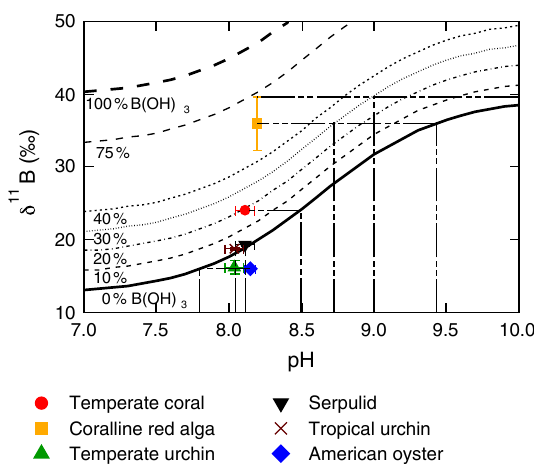
Figure 5. Exploring the potential influence of pH and boron spe- ciation on δ 11 B CaCO (adapted from Rollion-Bard et al., 2011b). 3 The solid and dashed curves represent the δ 11 B CaCO that would 3 result from the incorporation of different amounts of B(OH) 3 into the biogenic carbonates. The dashed vertical lines represent the cal- culated pH CF based on the assumptions that 0% B(OH) 3 is incor- porated into the temperate coral skeleton, American oyster shell, and temperate urchin spicule and that 0 and 30% B(OH) 3 are in- corporated into the coralline algal skeleton. Of all species exam- ined, only the coralline algae has a δ 11 B CaCO composition that 3 could conceivably originate at least in part from B(OH) 3 incorpora- tion, although this would require a much higher level (ca. 3-fold) of skeletal B(OH) 3 incorporation than has been previously observed (e.g., Cusack et al., 2015; see text for more details). However, there is no clear evidence of B(OH) 3 incorporation based on studies of biogenic or synthetic aragonite (see text for